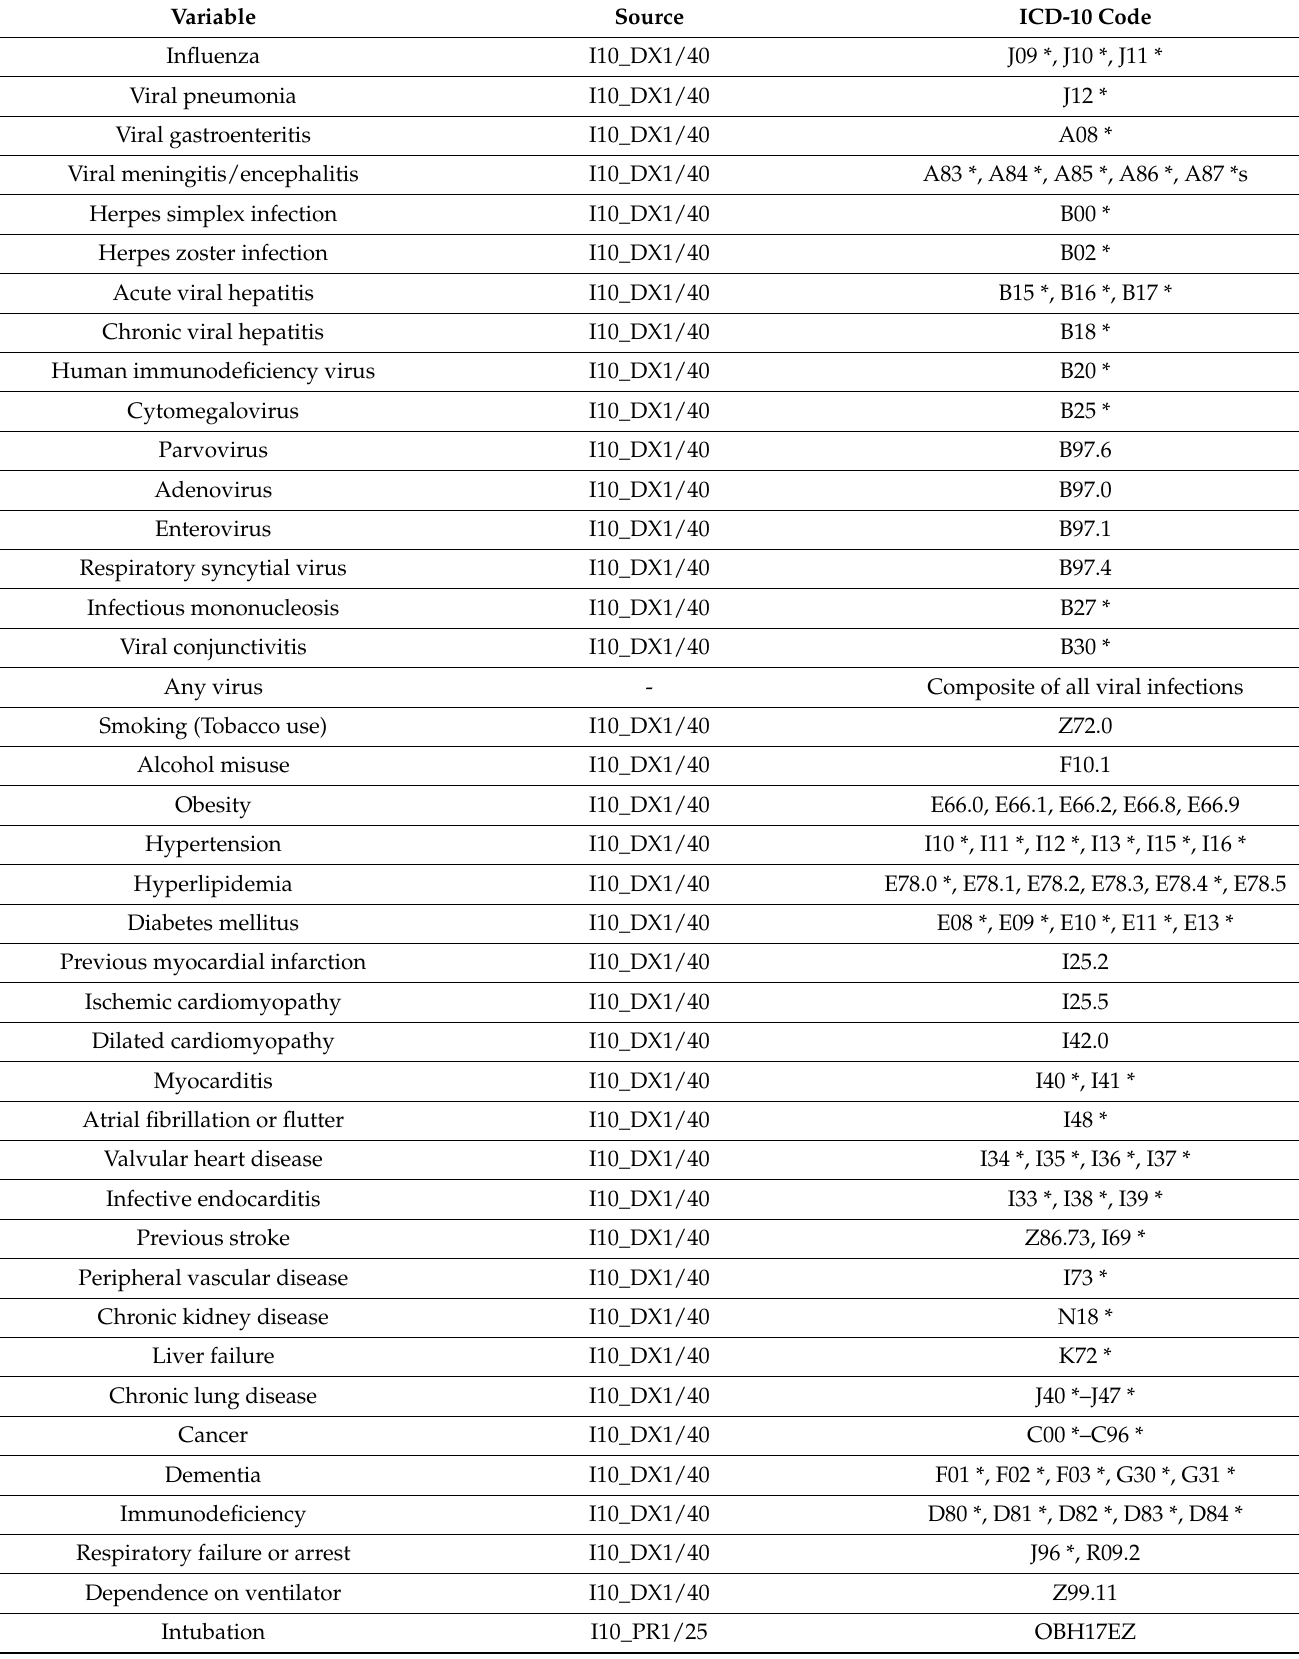
Table A1. Codes for data analysis and their